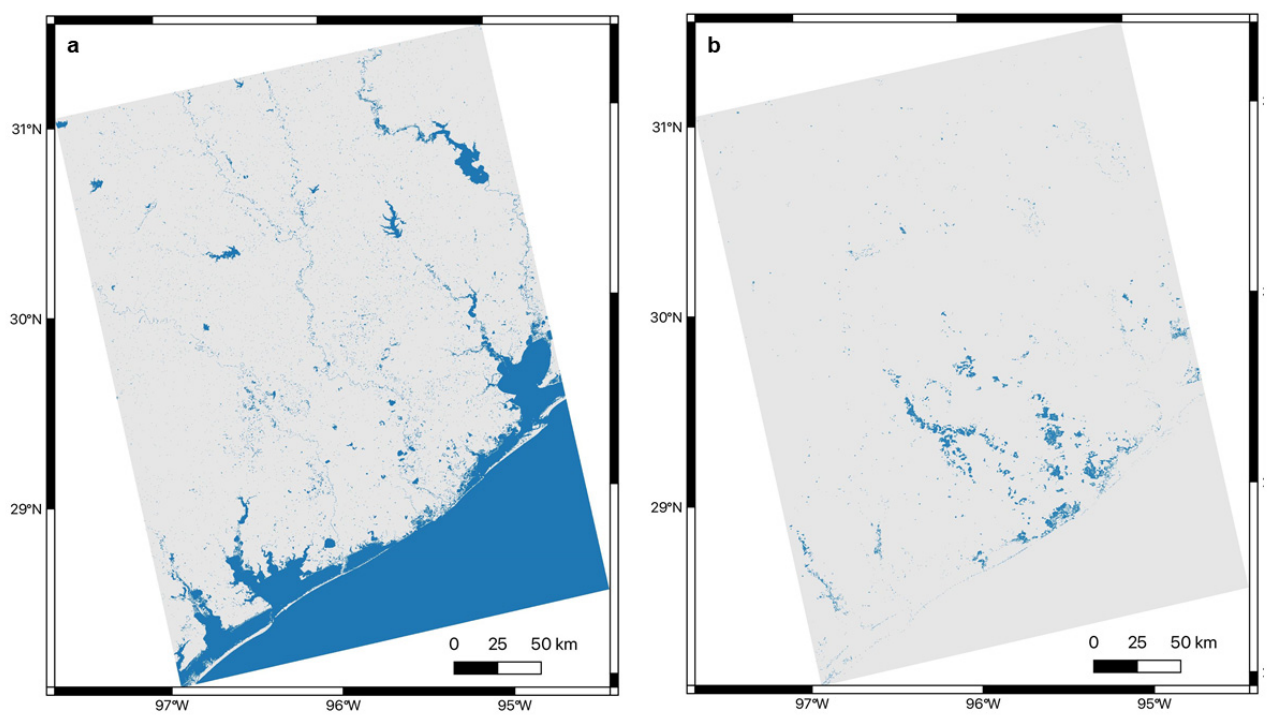
Figure 3. ( a ) GWM (water pixels in blue) [https://global-surface-water.appspot.com/download (accessed on 17 May 2021)]; ( b ) MODIS-derived flood inundation, 250 m pixel spacing, for 28 August– 4 September 2017, courtesy of DFO (water in blue) [41], with the GWM removed to characterize temporary water only.